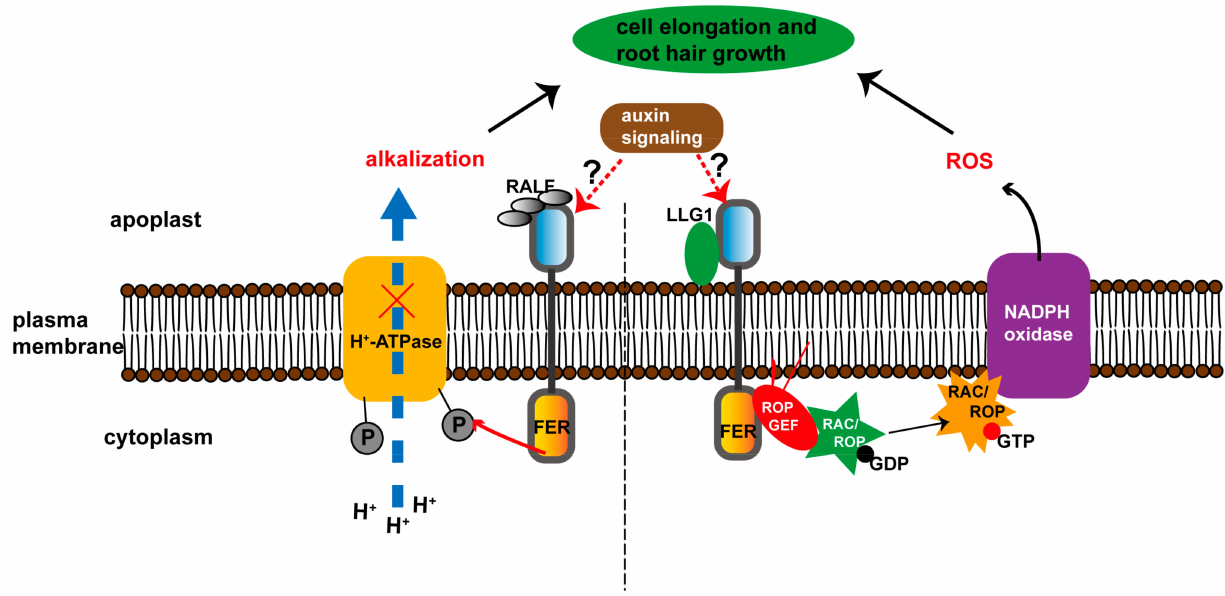
Figure 1. Schematic representation of the roles of FER in auxin-induced cell elongation and root hair growth. Two pathways have been reported to depict the roles of FER in auxin-induced root hair growth. In the first one, in the right side of the figure, FER regulates NADPH oxidase-dependent ROS accumulation through RAC/ROP to participate in auxin-induced root hair growth [12]. Specifically, the FER–ROPGEF module preferentially binds RAC/ROP in a GDP-dependent manner; upon signal activation, activated GTP-bound RAC/ROPs interact with NADPH oxidase to mediate ROS production, leading to root hair growth [12]. Additionally, LLG1 is a key component of the FER– ROPGEF–RAC/ROP signaling complex [24]. In the second pathway, on the left side of the figure, auxin regulates cell elongation by modulating the apoplast acidification in a FER-dependent manner. Specifically by binding its RALF ligand, FER induces phosphorylation of plasma membrane-localized H + -ATPase to inhibit proton transportation into the apoplast